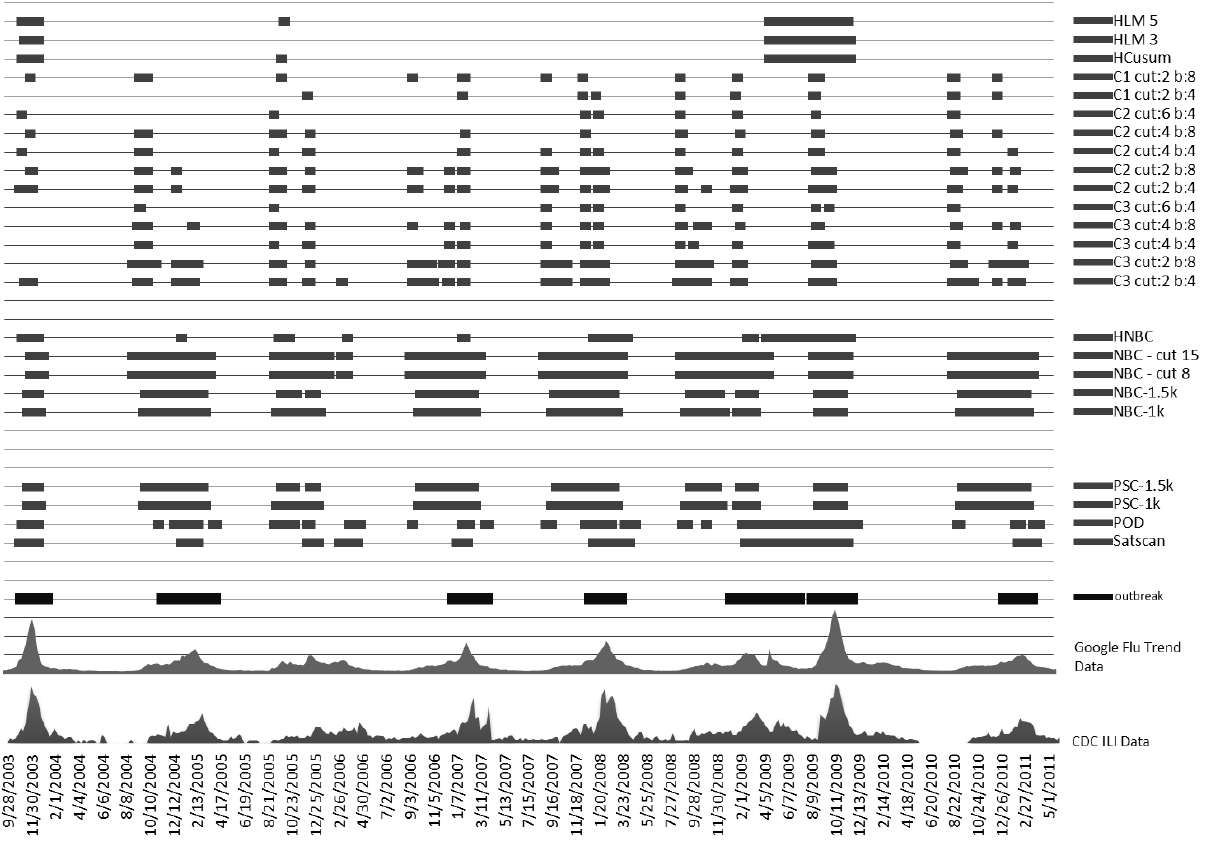
Figure 12. US Department of Health and Human Services region 10. The x-axis plots the Google Flu Trends and Centers for Disease Control and Prevention (CDC) data. The horizontal bars indicate where each method detected an epidemic. Cut indicates cut-off point (more is less sensitive) and b indicates baseline data (training window). The thick horizontal bar at the bottom shows actual outbreak. HCusum = historical cumulative sum, HLM = historical limits method, HNBC = historical negative binomial cumulative sum, ILI = influenza-like illnesses, k = reference value for threshold, NBC = negative binomial cumulative sum, POD = Poisson outbreak detection, PSC = Poisson cumulative sum.